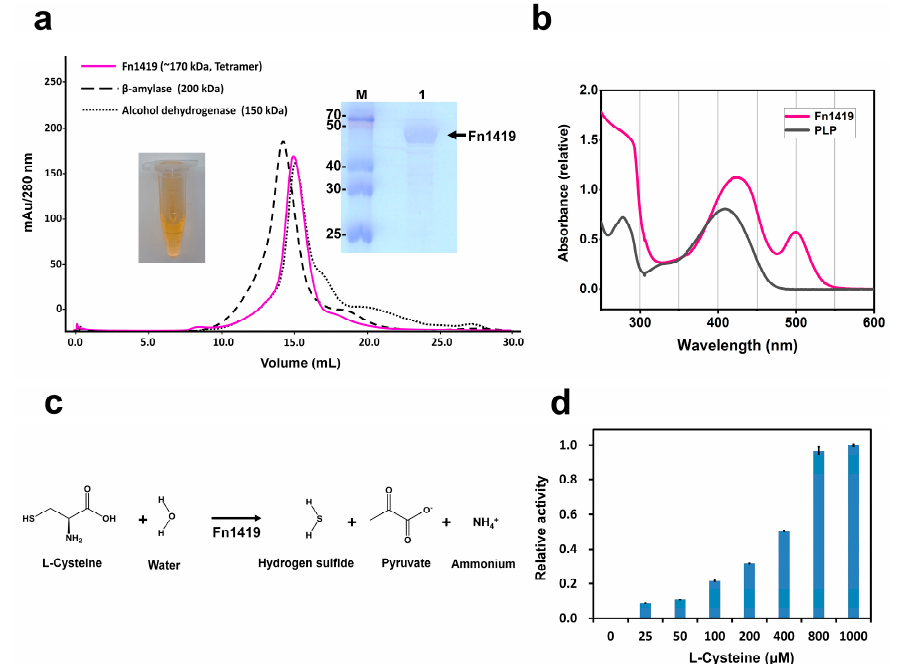
Figure 1. Characterization of the PLP-binding and MGL Cys activity of Fn1419. ( a ) Profile of size- exclusion chromatography of Fn1419, showing the tetramer state in solution. (insert, left) The concentrated Fn1419 solution with yellow coloration. (insert, right) Purified Fn1419 on SDS-PAGE. ( b ) Spectroscopic analysis of Fn1419. The PLP and PLP-bound Fn1419 exhibited absorption peaks at 420 and 425 nm, respectively. ( c ) Reaction mechanism of F. nucleatum Fn1419 with L-cysteine. ( d ) The MGL Cys activity of purified Fn1419 with different concentrations of L-cysteine. The error bars represent the standard deviation of three replicates.